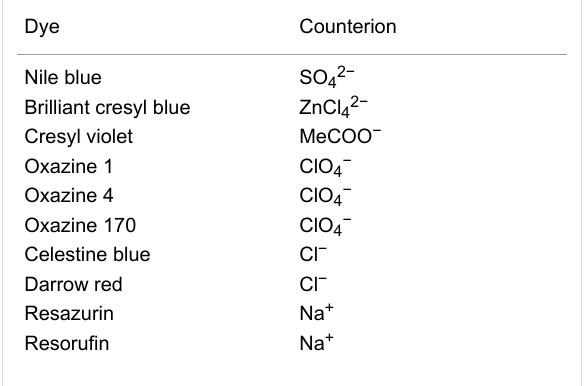
Table 5: Counterions of each oxazine dye.